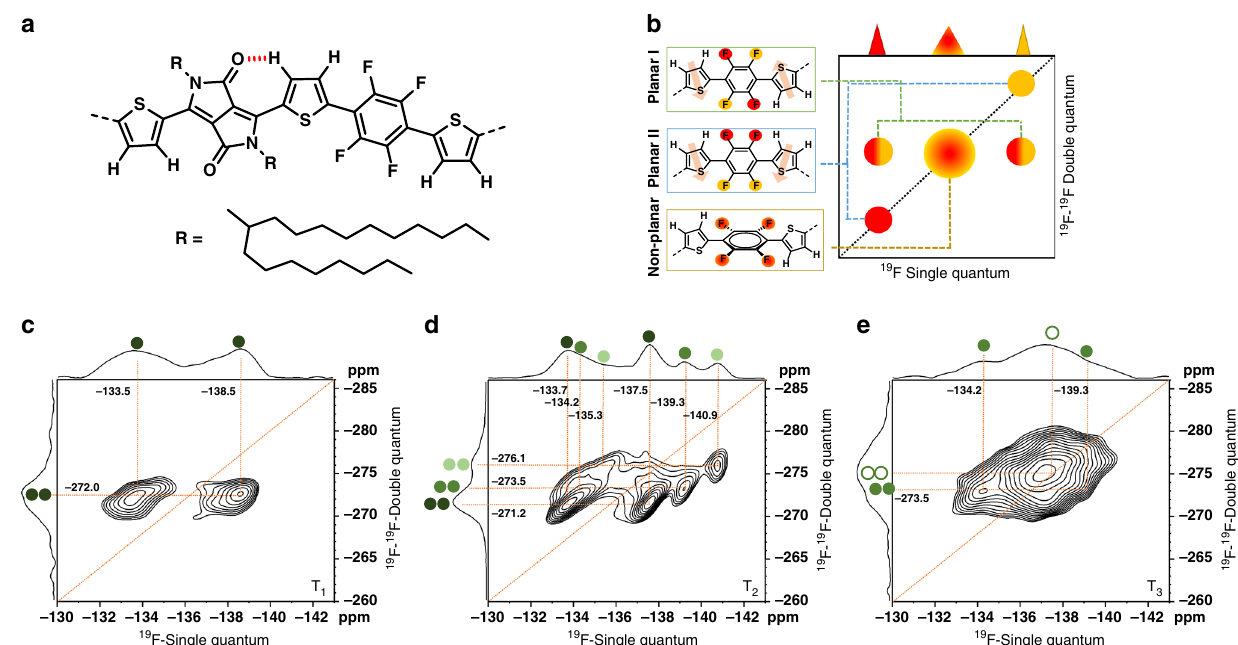
Fig. 4 Solid-state NMR data. Results from 19 F- 19 F solid-state NMR. a Conformation of the polymer backbone inside the ordered domains after annealing at T 19 F- 19 F DQ-SQ correlation spectra shown in c – e : while only one broad pair of cross-correlations 1 . b schematic representation for the interpretation of the is observed after annealing at T 1 , three new cross-correlation pairs with signi fi cantly narrower lines are observed after annealing at T 2 . Annealing at T 3 leads to mostly non-planar conformations around the F4